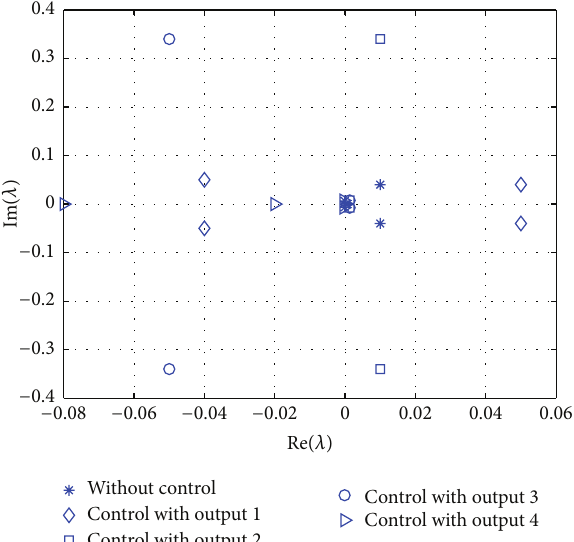
Figure 3: Eigenvalues 𝜆 of the aeroelastic model with different output controllers for divergence instability case ( 𝑈 = 24